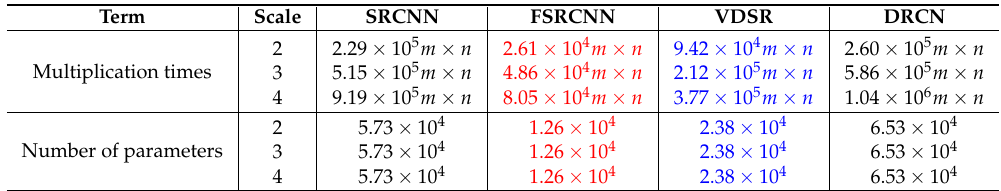
Table 12. The comparison of computational complexity for an input image of size m indicates the best performance, while the blue font indicates the second best.